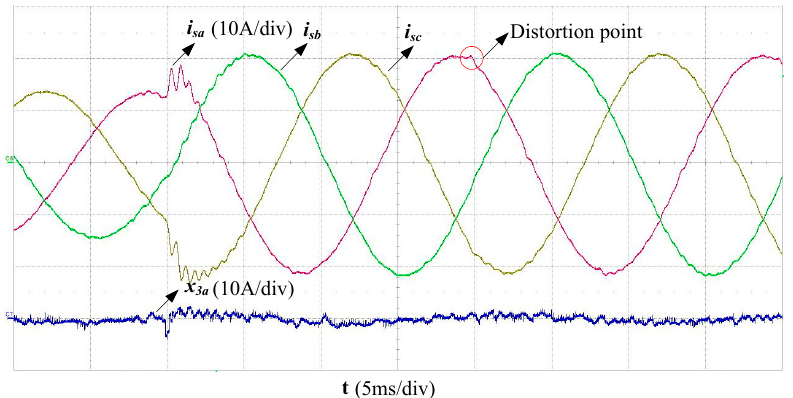
Figure 16. Experimental waveform of SAPF based on MRSMC in dynamic state.